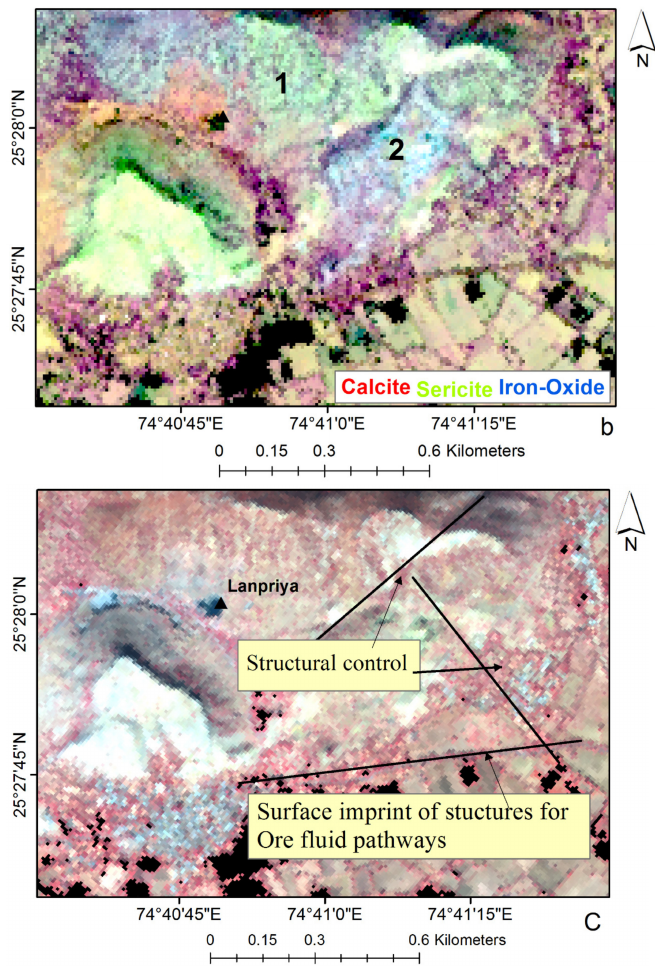
Figure 14. ( a ) FCC of fit images of multirange SFF algorithms detecting quartzite, amphibolite, and Calc-silicates. ( b ) Surface imprints of sericitization (1) and Gossanization (2) are also associated with the quartzite. ( c ) Structural control or the trace of the fault plan which might have facilitated fluid migration in the AVIRIS NG. In the AVIRIS image, Red = 850 nm, Green = 650 nm and Blue = 560 nm.